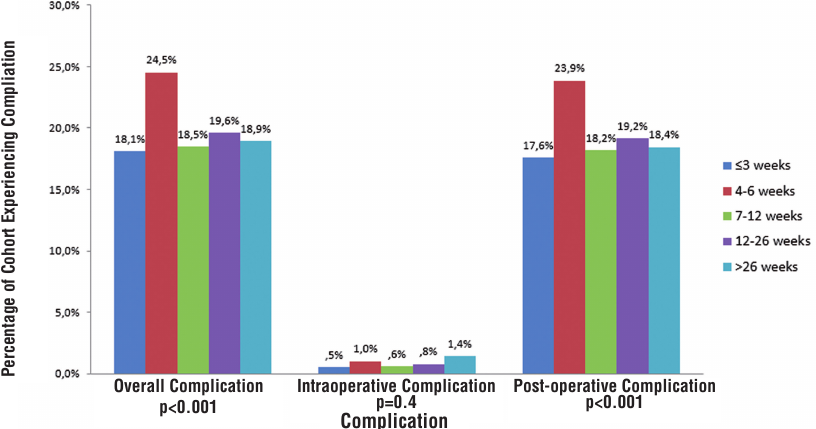
Figure 2 - Complications stratified by time from Biopsy to Radical Prostatectomy.